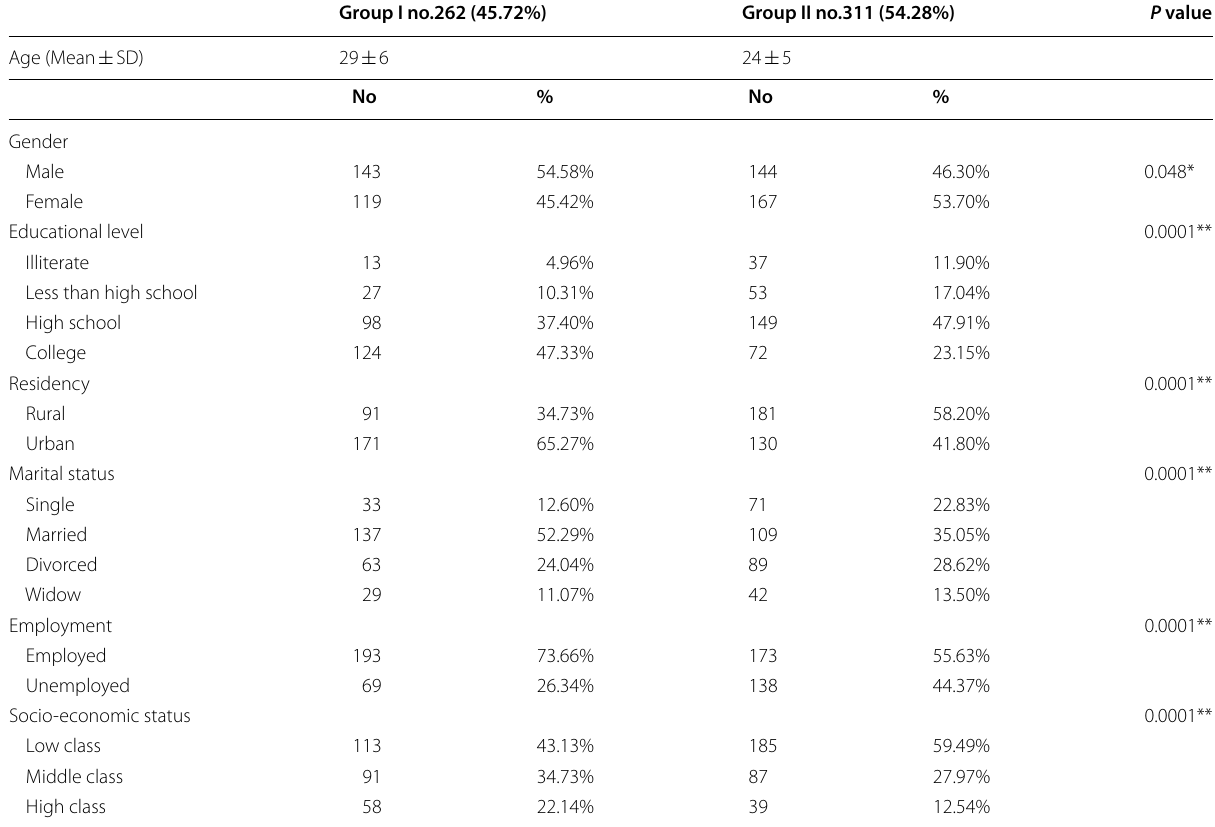
P value < 0.05 is considered statistically significant (*). P value < 0.001 is considered highly significant (**)